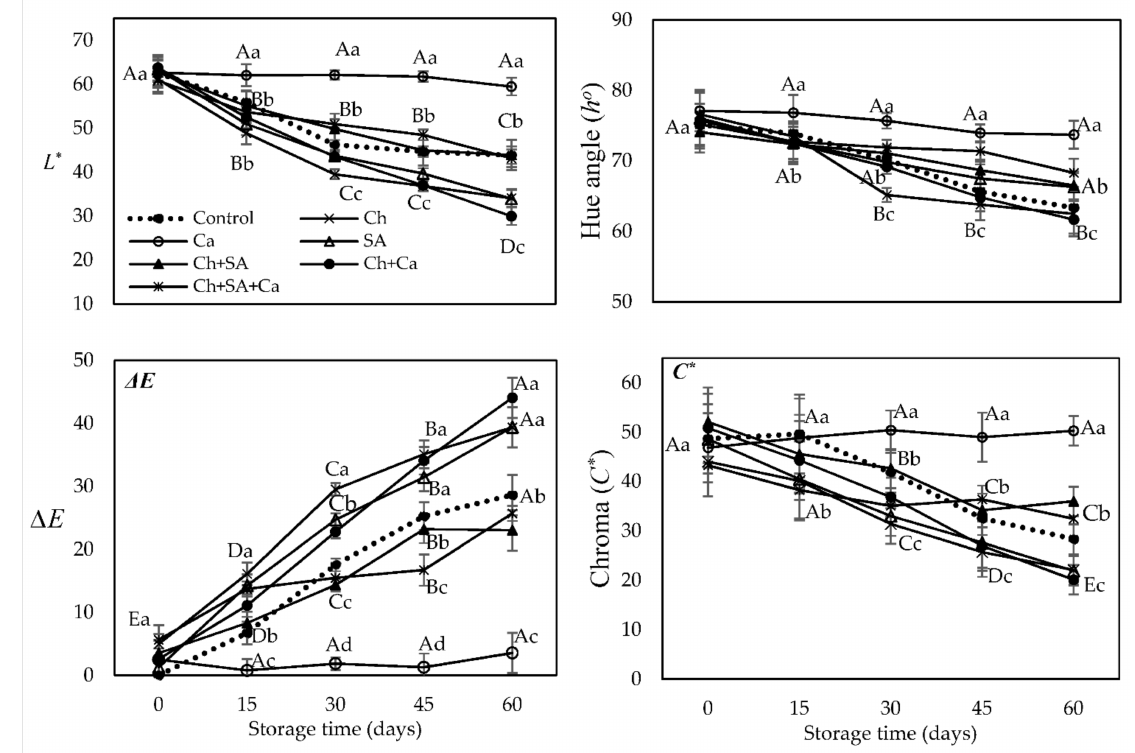
Figure 3. Effects of preharvest treatments with natural elicitors on “Barhi” fruit’s color during cold storage for two months; values are the mean (n = 25) ± SE. The LSD test at p ≤ 0.05 was used to compare the means between treatments. Means with the same letter(s) between treatments within storage time intervals (small letter) and at different time intervals (capital letter) are not significantly different. Ch: chitosan; SA: salicylic acid; Ca: calcium chloride.